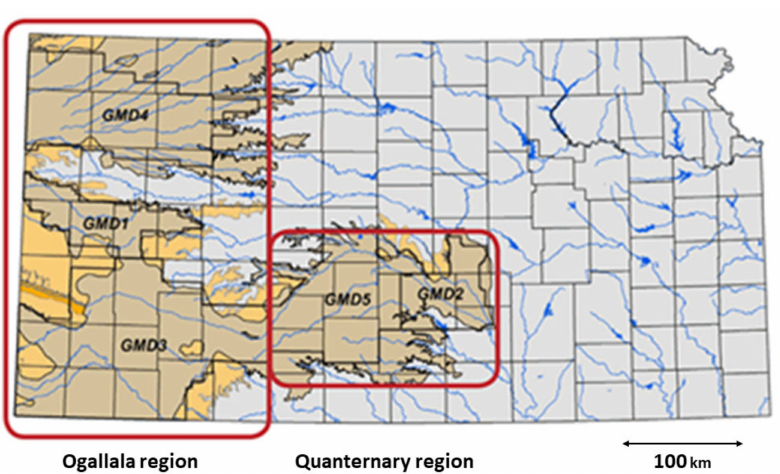
Figure 1. Groundwater Management Districts No. 1, 3, and 4 located in the Ogallala Region of the Kansas High Plains Aquifer. Source: Whittemore et al.